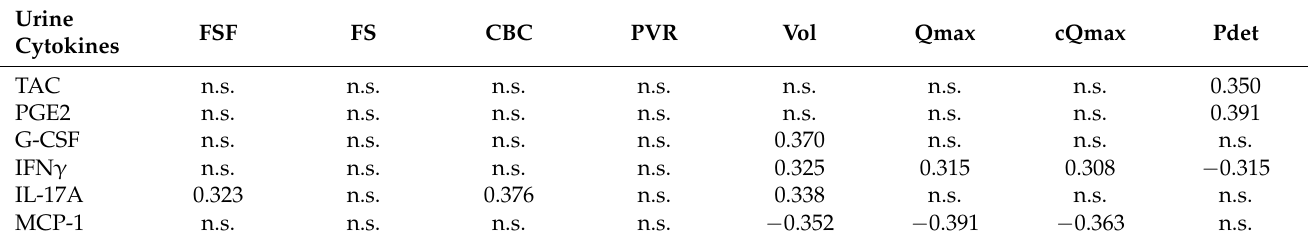
Table 4. The correlation coefficient (r value) between urine biomarker levels and VUDS parameters in patients with DU.